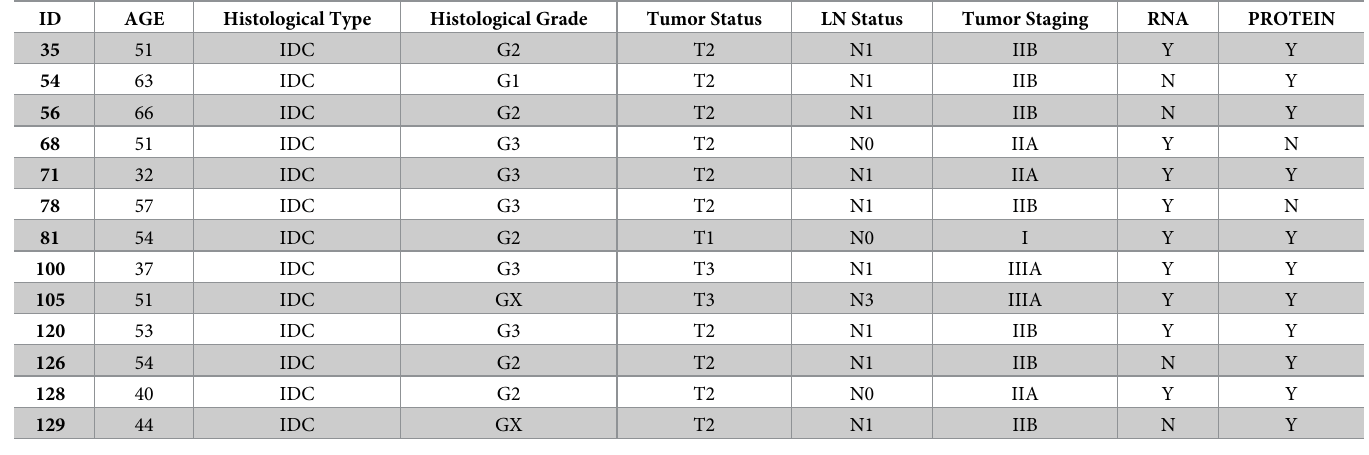
Table 3. Lapatinib-treated HER2+/ER+ tumors g